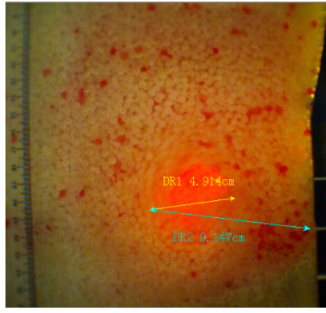
Figure 5. Raceway behaviour in the experiment.